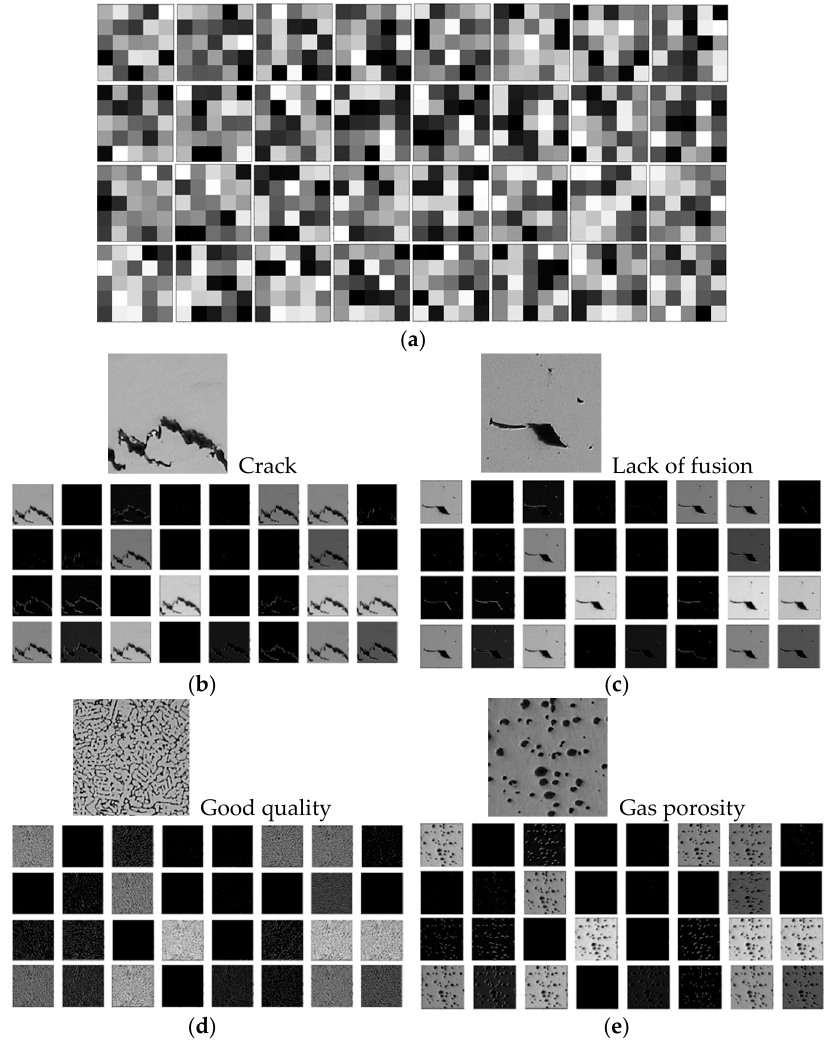
Figure 7. Visualization of the ( a ) 32 learned filters of the first convolutional layers, ( b ) 32 feature maps for a crack sample, ( c ) 32 feature maps for a lack of fusion sample, ( d ) 32 feature maps for a good sample and ( e ) 32 feature maps for a gas porosity sample.